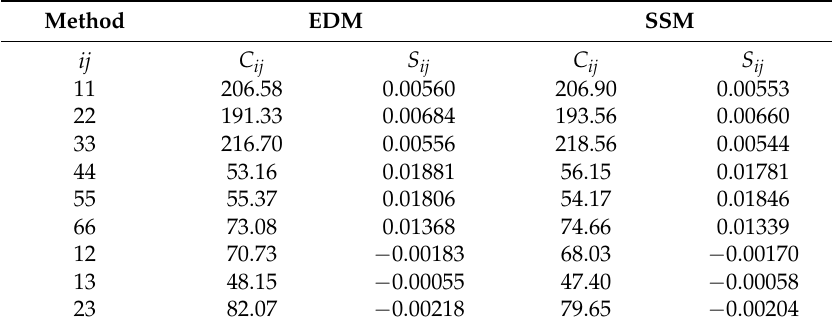
Table 3. The elastic stiffness ( C ij in GPa) and compliance ( S ij in GPa − 1 ) constants of B19 TiAl.